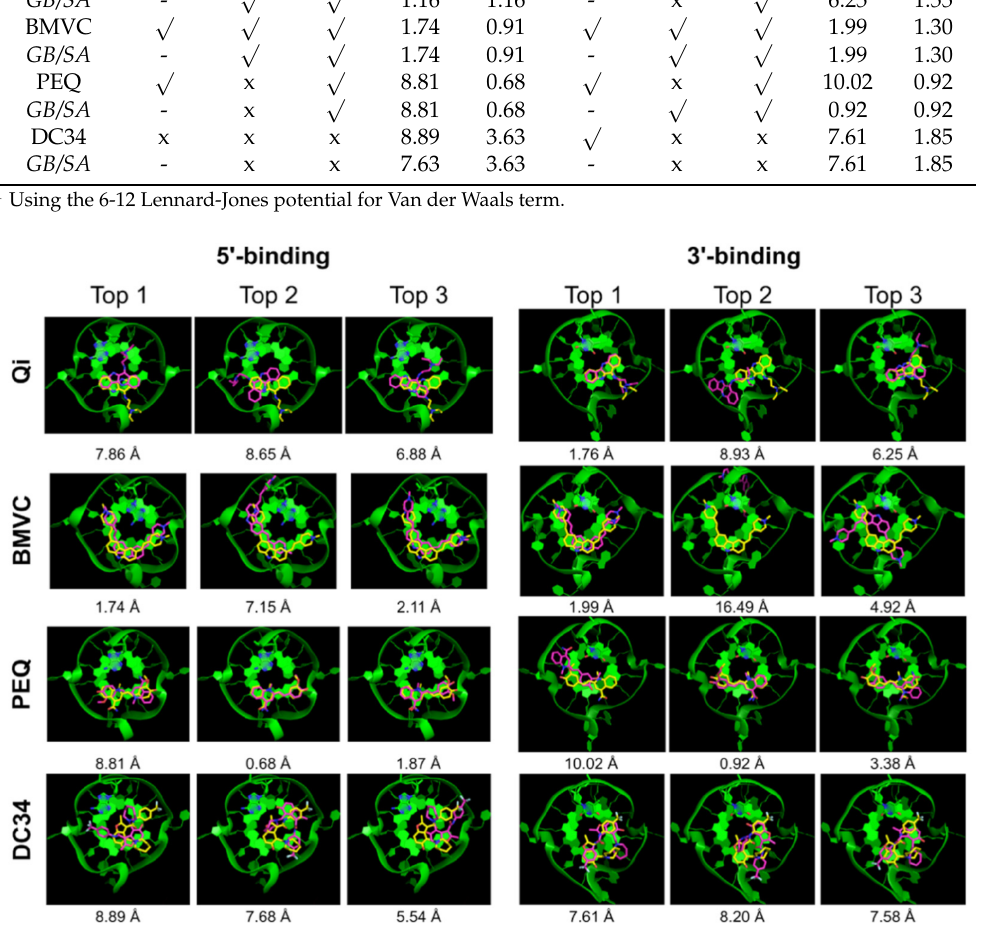
Figure 3. DOCK 6 top 3 docked poses (purple) superimposed onto the NMR poses (yellow). The G4 DNA is shown as green